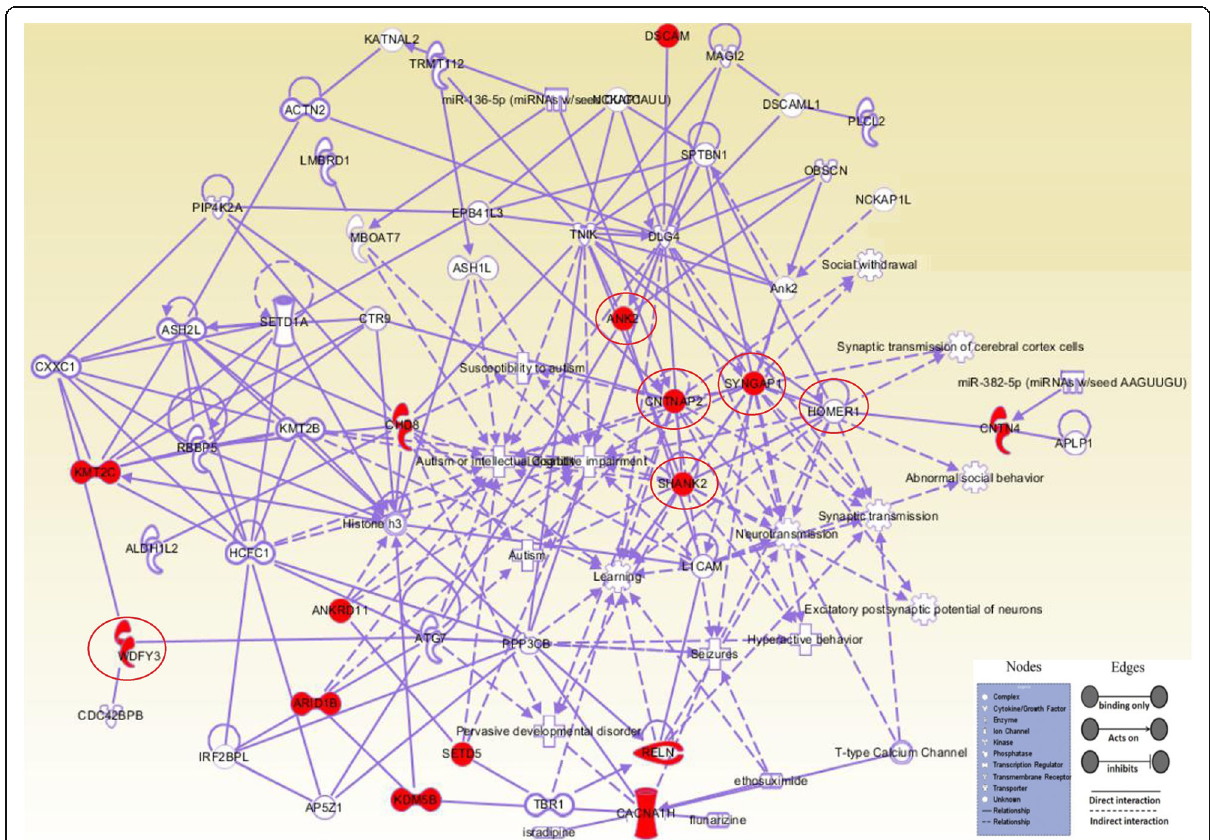
Fig. 2 Pathway analysis for the high-risk autism genes using Ingenuity Pathway Analysis (IPA). Clustered protein within the top network- associated genes as derived from IPA algorithms is shown. Proteins identified are encircled and labeled with the protein symbol in red fill. Direct connections between/among proteins are shown in solid lines; indirect interactions are shown as dashed lines or edges. The constructed pathways analysis of the 15 high-risk genes has shown an association with various autism phenotypes and processes, including learning, synaptic transmission, abnormal social behavior, and social withdrawal. These genes coincide with multiple pathways with overlapping connections across different pathways and present in the upstream and downstream of vital processes. Each gene has a divergent and convergent pathway and